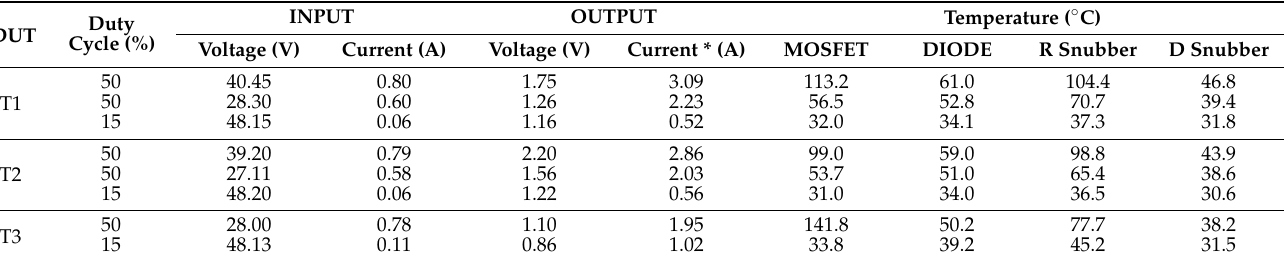
Table 3. Measured operating conditions in the flyback converter prototype.